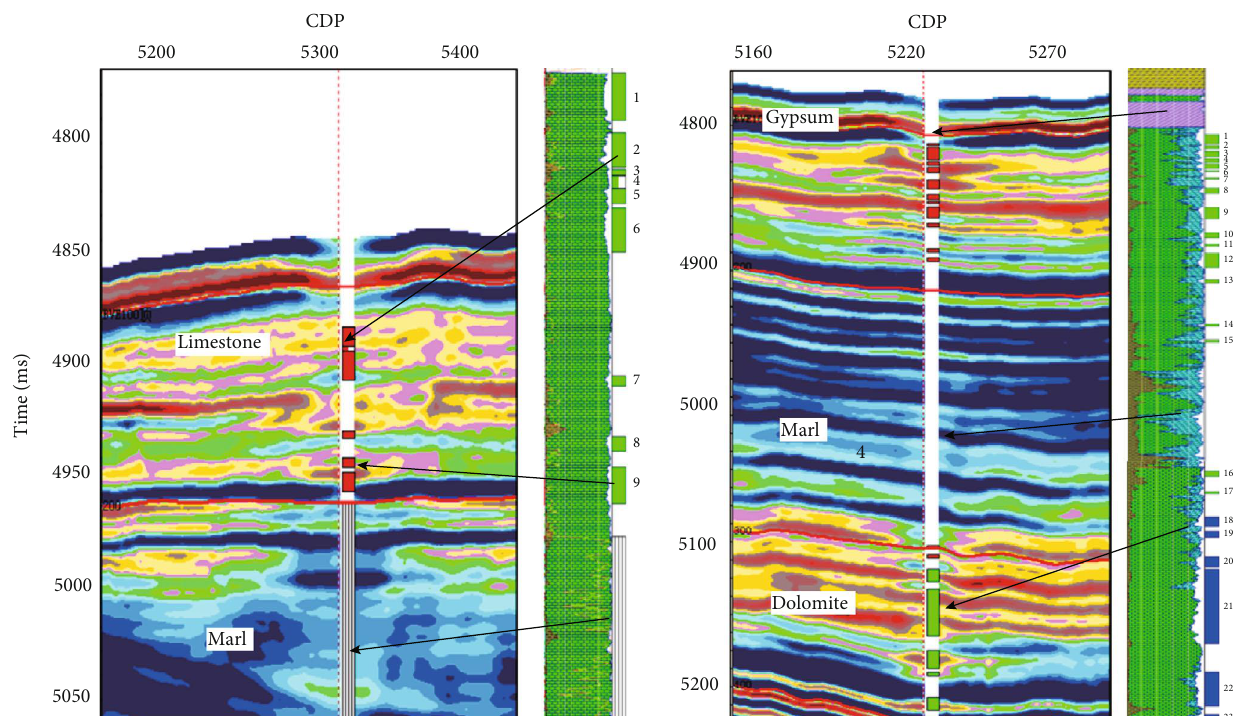
Figure 11: The acoustic impedance inversion pro fi les of the di ff erent lithologies.